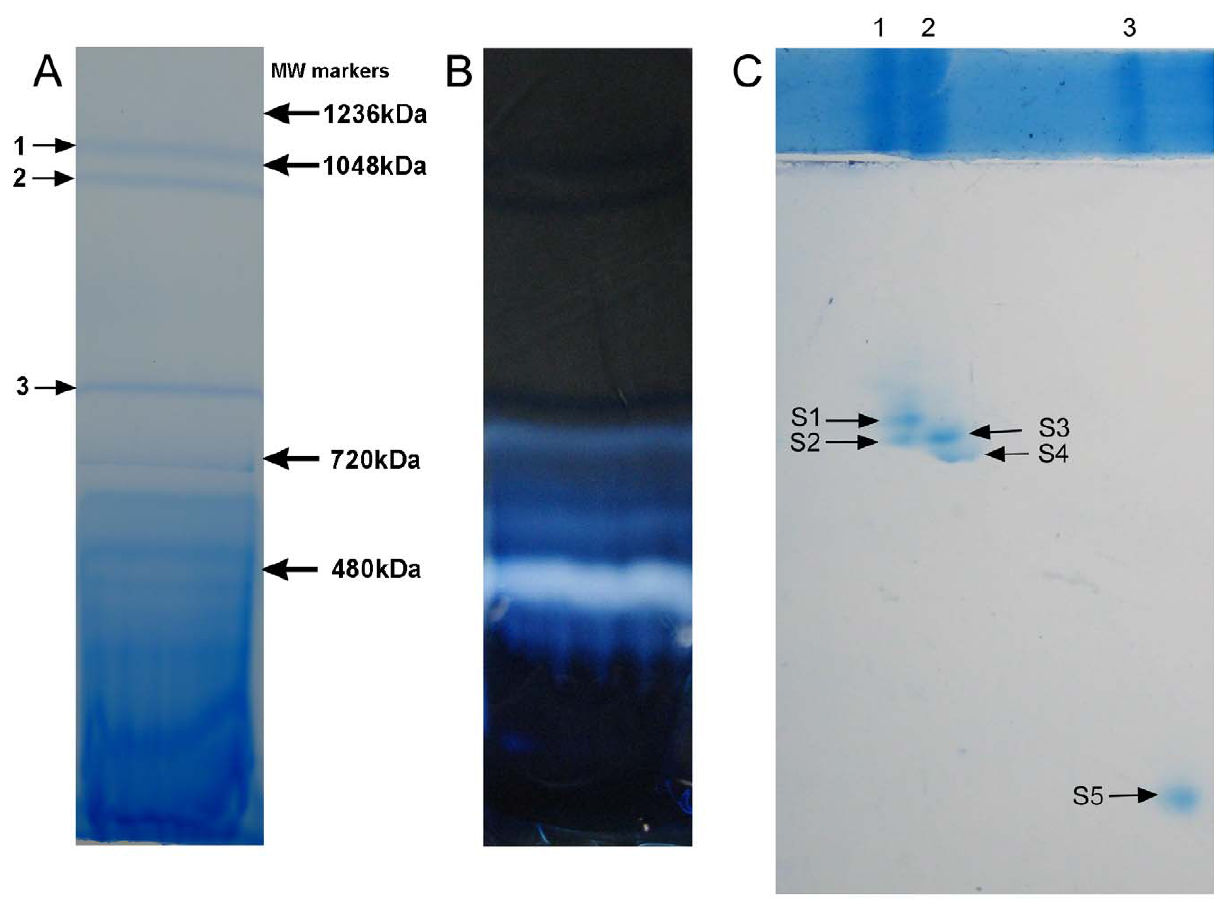
Figure 2. BN-PAGE of solubilized T.thermophila mitochondrial membranes. (A)BN gel (3%–10%) run with T. thermophila mitochondria(1 mg) solubilized with digitonin (5 m g of detergent/ m g of protein), and stained with colloidal Coomassie blue. (B) In-gel ATPase staining of a BN gel strip of digitonin-solubilized T. thermophila mitochondria. The gel was incubated overnight (8–12 h) and was briefly (2 min) washed with 10% acetic acid to remove excess lead precipitate on the surface. (C) 2-D BN/BN-PAGE. The first dimension was completed as in (A) and a strip was excised and briefly soaked in cathode buffer containing 0.03% docecyl maltoside (the strip shown here above the 2-D gel is a second strip cut from the same 1-D BN-PAGE that was stained with Coomassie blue; the image of the strip was cropped below the position of band 3). The second dimension was a 4%–12% gradient BN-PAGE run with 0.03% dodecyl maltoside in the cathode buffer (see Materials and Methods). The band 1 (V 2 , I + III 2 , II 2 ) separated into two spots designated as spot 1 and 2. The band 2 (V 2 , I + III 2 ) separated into two spots designated as spot 3 and 4, while band 3 (III 2 ) ran as a single spot, labeled as spot 5. The image of the 2-D gel was cropped on the right side so that most of the material running below band 3/spot 5 is not shown.